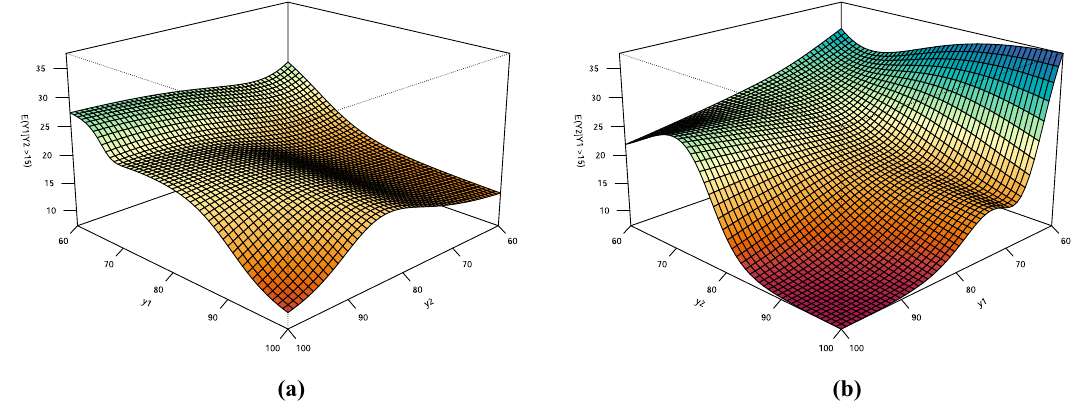
Figure 11: Marginal expected excess survival times, conditional on spouse survival during 15 years. ( a ) Man and ( b )